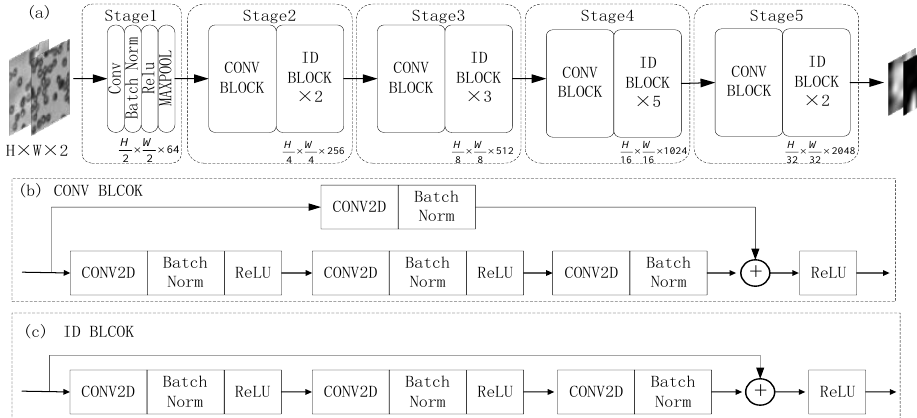
Figure 3. Migration ResNet50 base-layer network model framework: ( a ) schematic diagram of base-layer network model; ( b ) CONV BLOCK network structure module; ( c ) ID BLOCK network structure module.